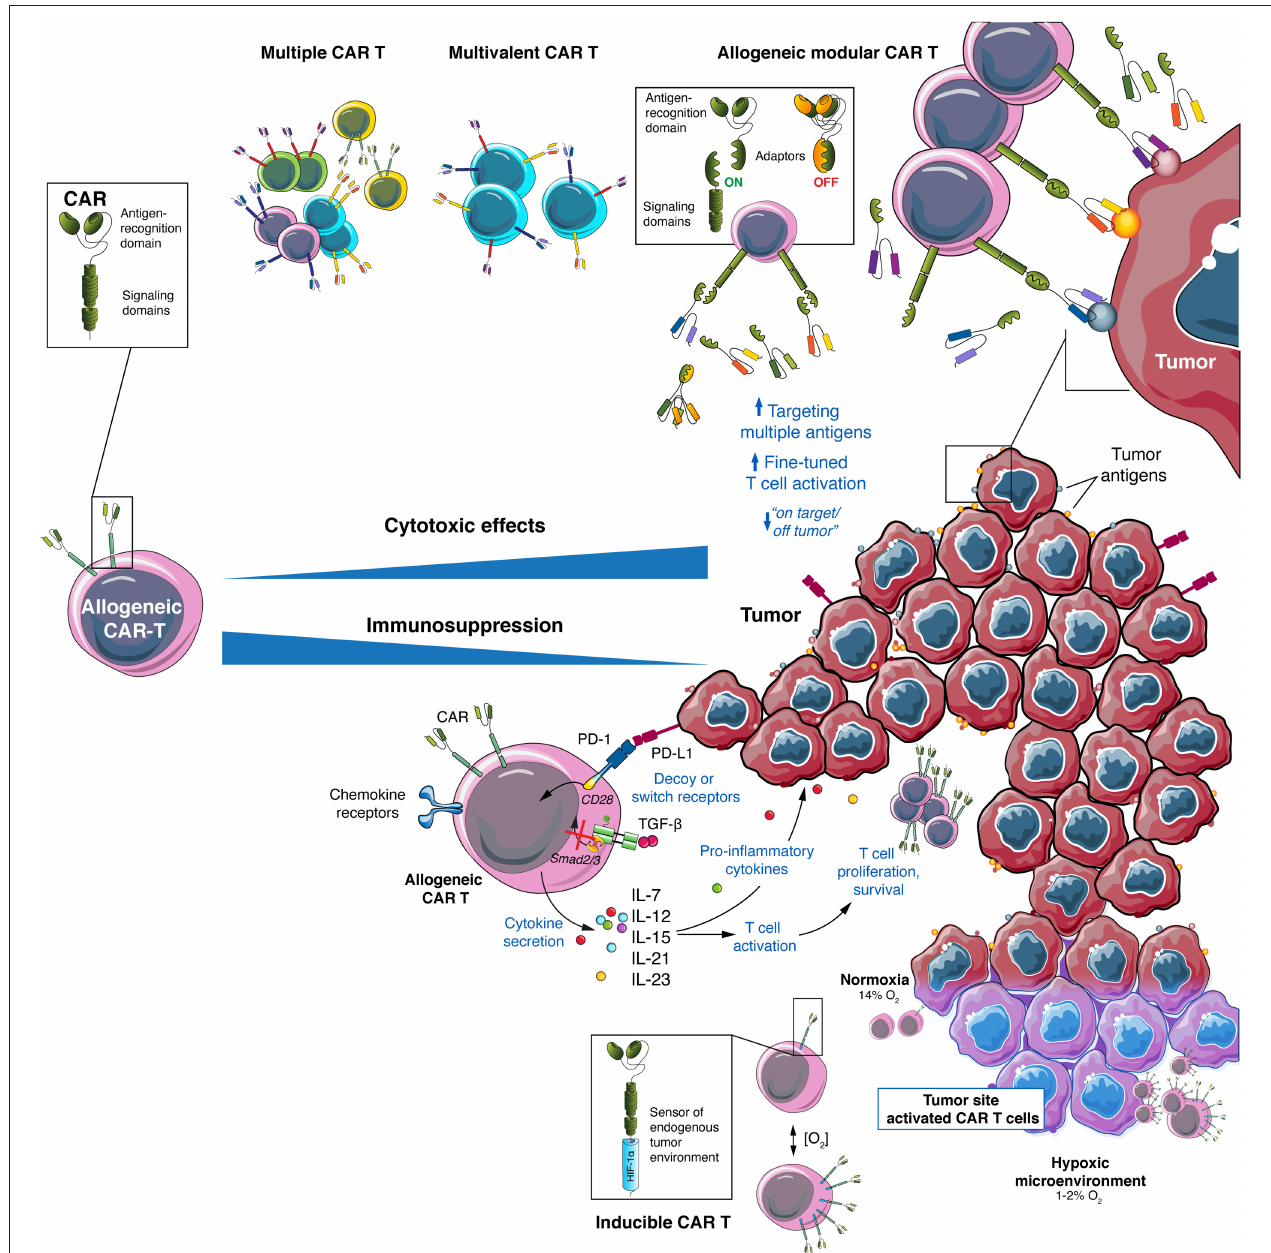
FIGURE 3 | Allogeneic CAR T cells provide a versatile platform to attack GBM and its environment. GBM heterogeneity require a multitarget approach that can be achieved using allogeneic CAR T cells using multiple CAR T cell mixes, multivalent CAR T cells or by modular CAR T combined with several adaptors. To overcome the immunosuppressive TME of GBM several strategies to engineer allogeneic CAR T cells can be used: secretion of pro-inflammatory cytokines (such as IL-7, IL-12, IL-15, IL-21, or IL-23), expression of decoy or switch receptors (to change immunosuppressive signals into activating ones), expression of chemokine receptors (to direct CAR T cells to the tumor site) and generation of locally activated CAR T cells (such as hypoxia-inducible CAR T